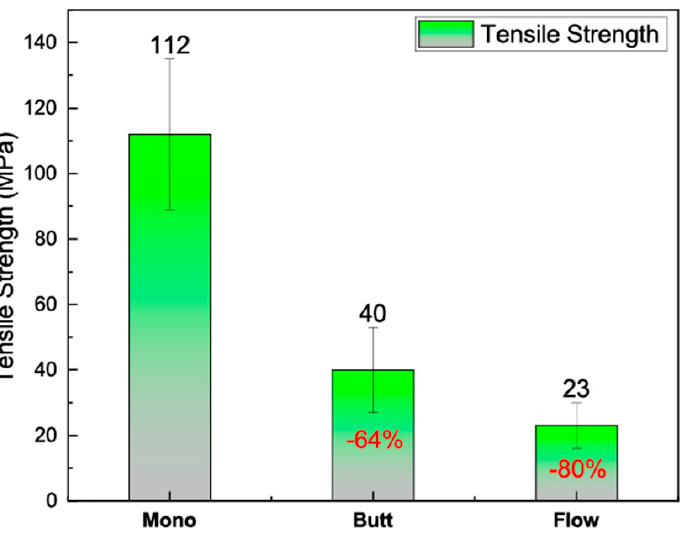
Figure 6. Tensile strength results of the three different charge patterns. Strength reductions shown for the plaques with WLDs are compared to that of the Mono plaque